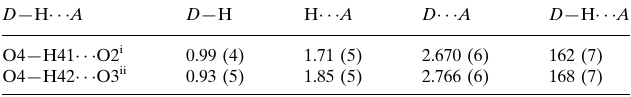
Hydrogen-bond geometry (A˚ , (cid:2)